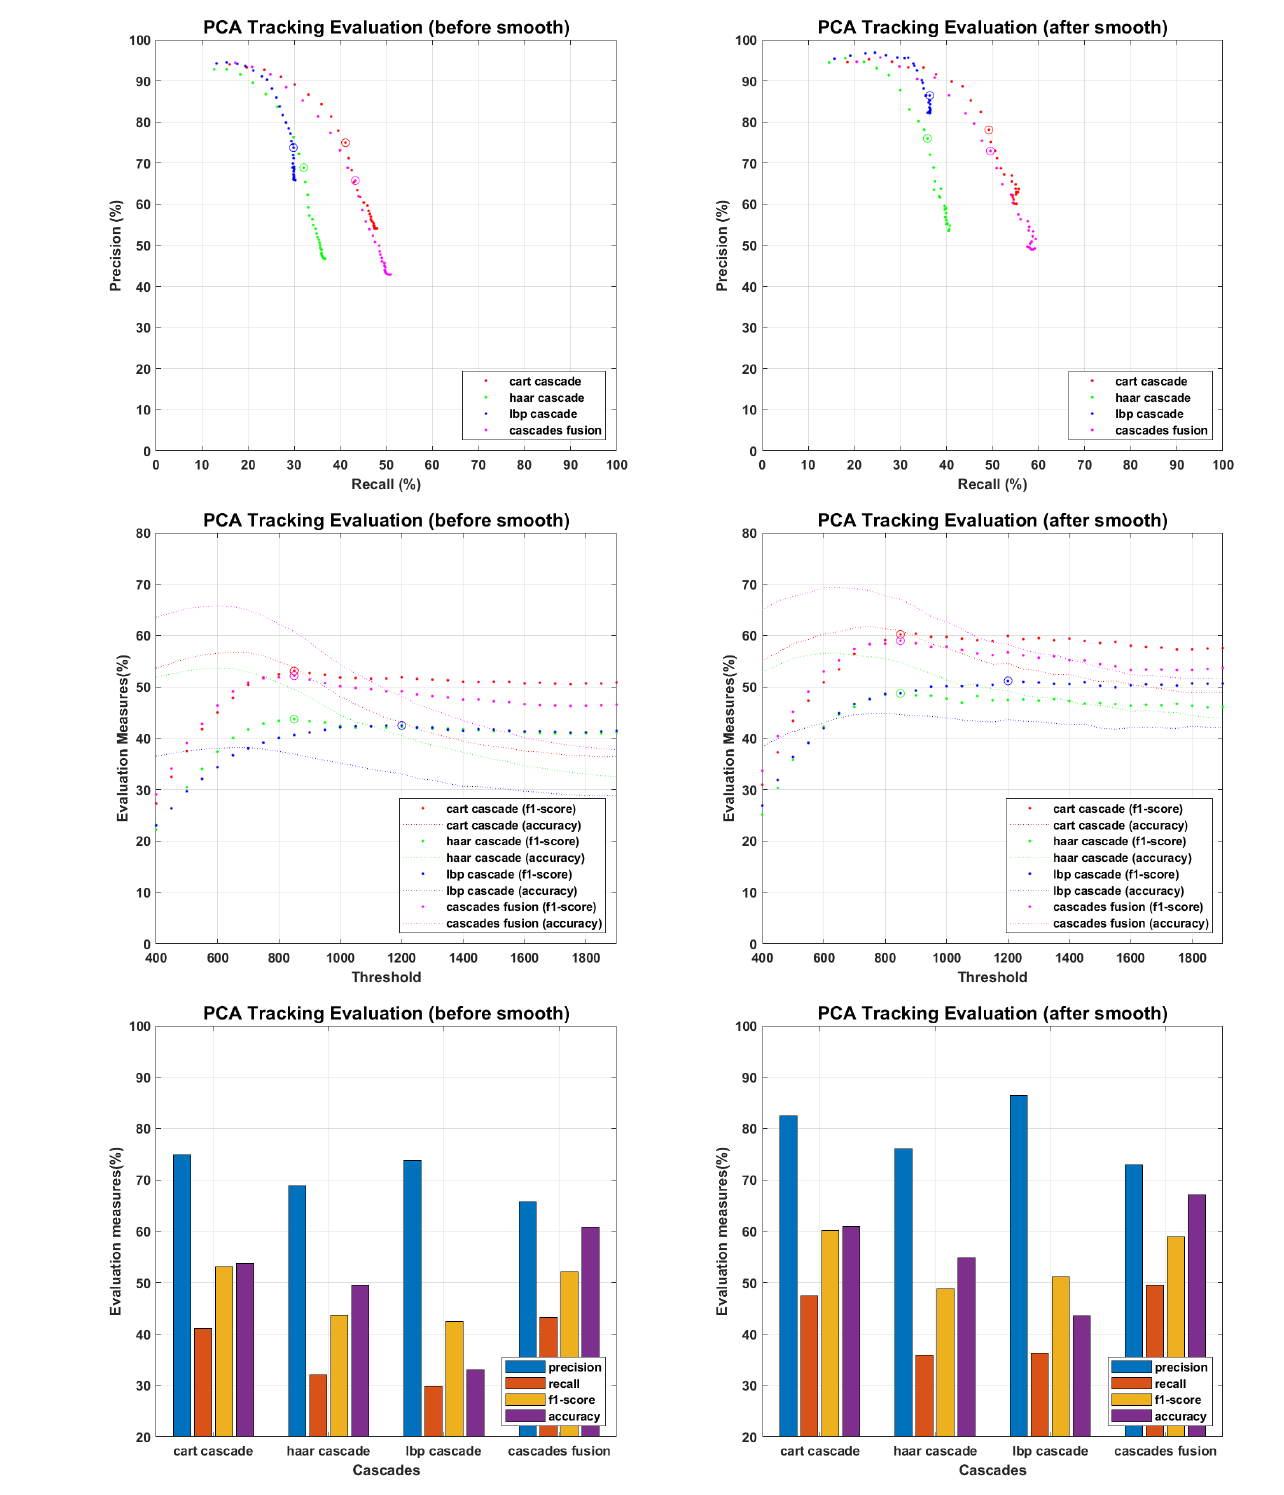
Figure 15. Tracking Evaluation for